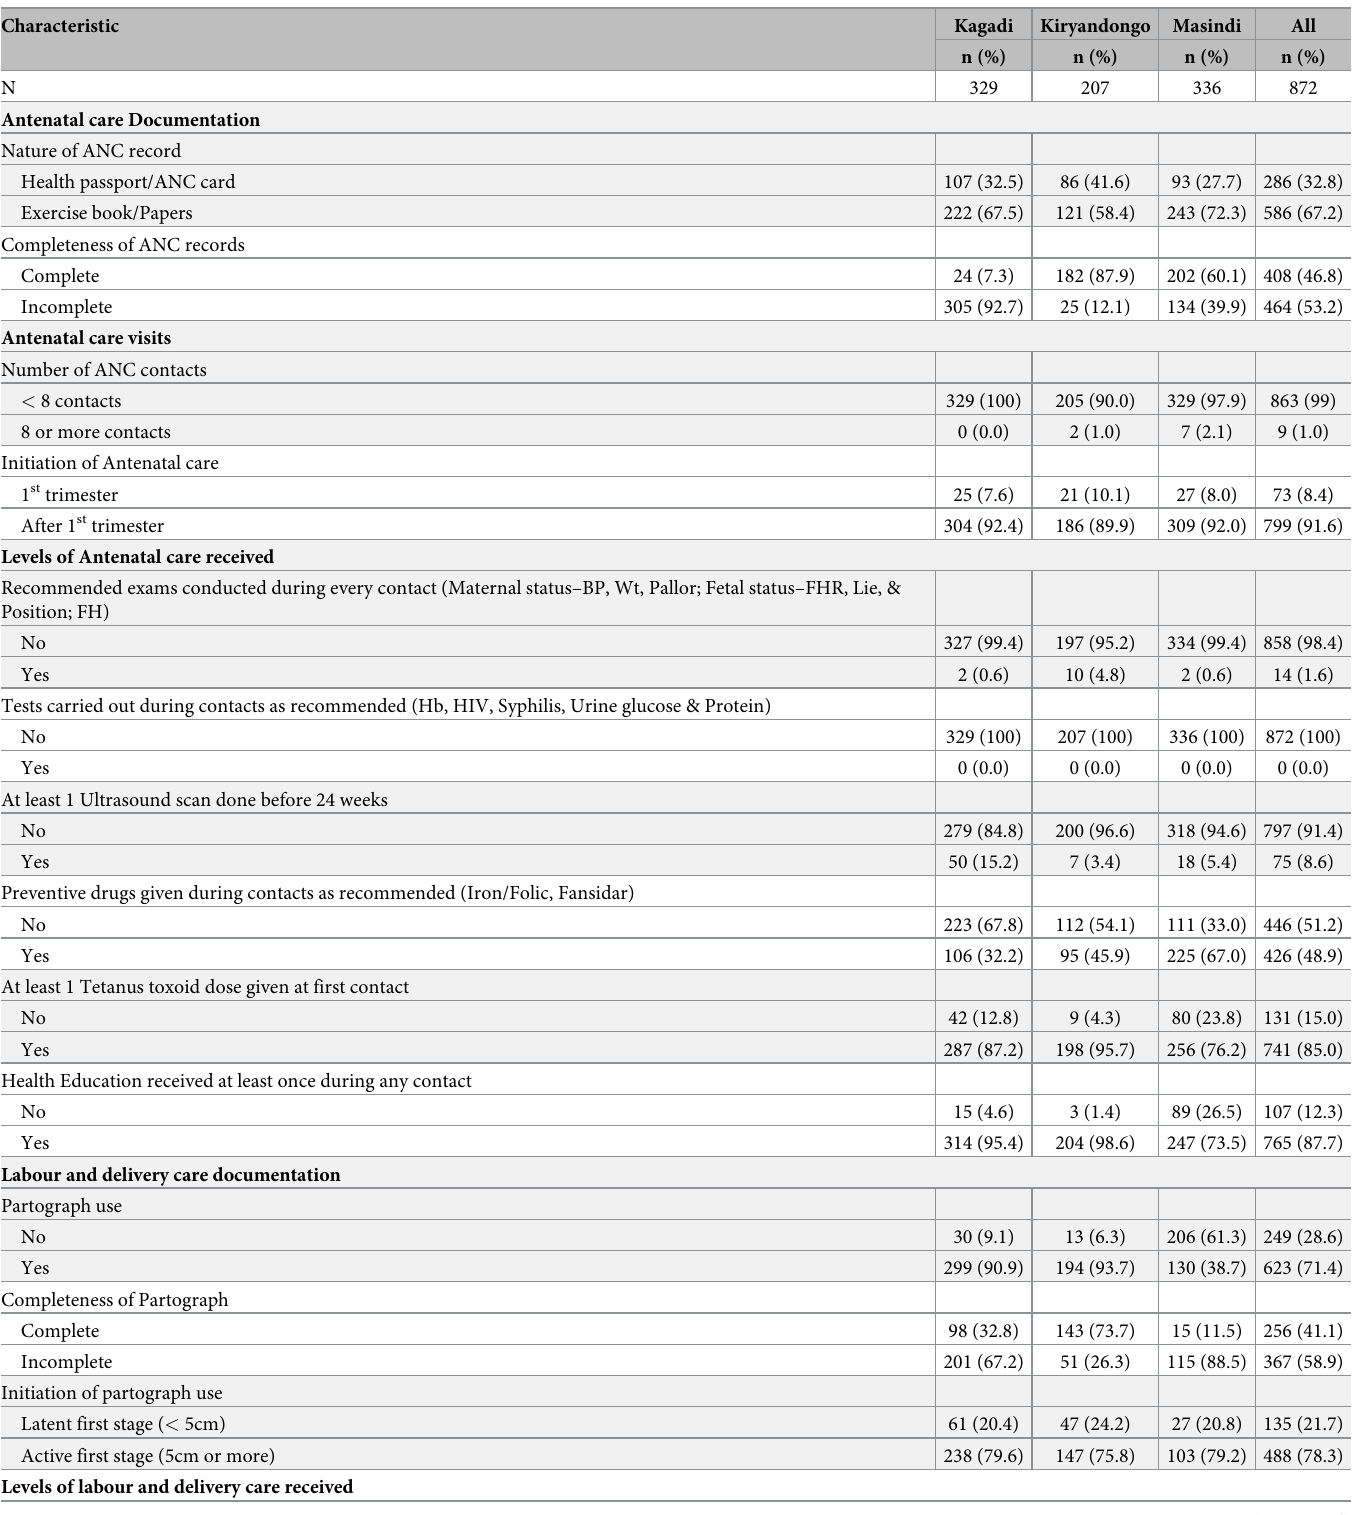
Table 3. Perinatal care received by